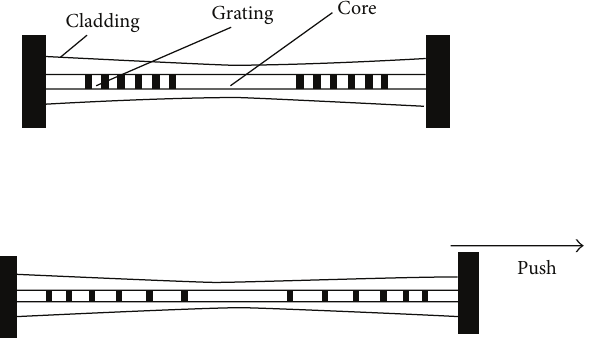
Figure 2: Sketch of sandglass FBG and applied stress.